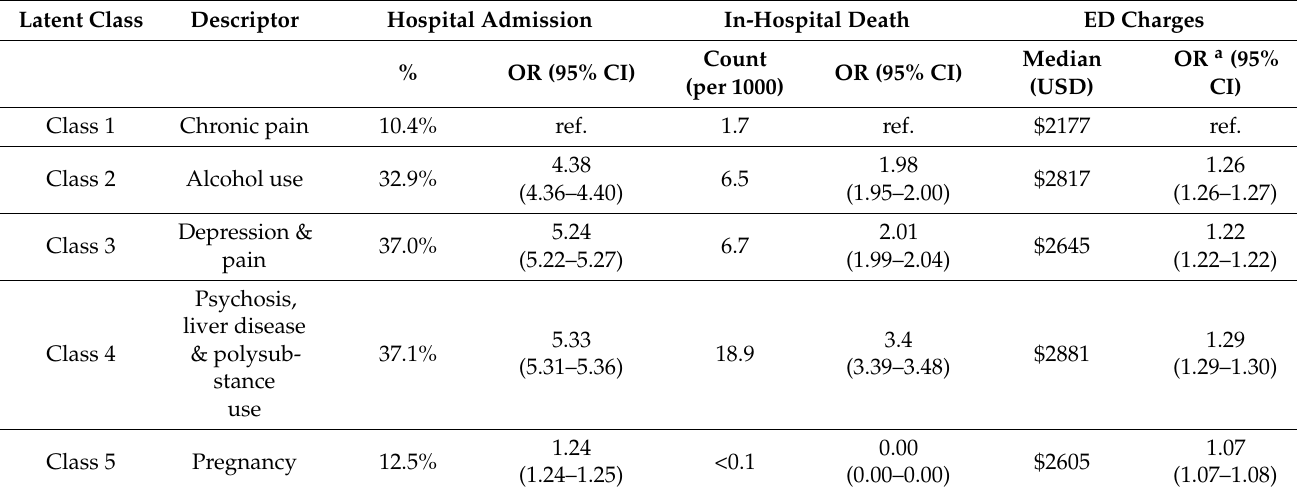
Table 4. Patient outcomes by latent class